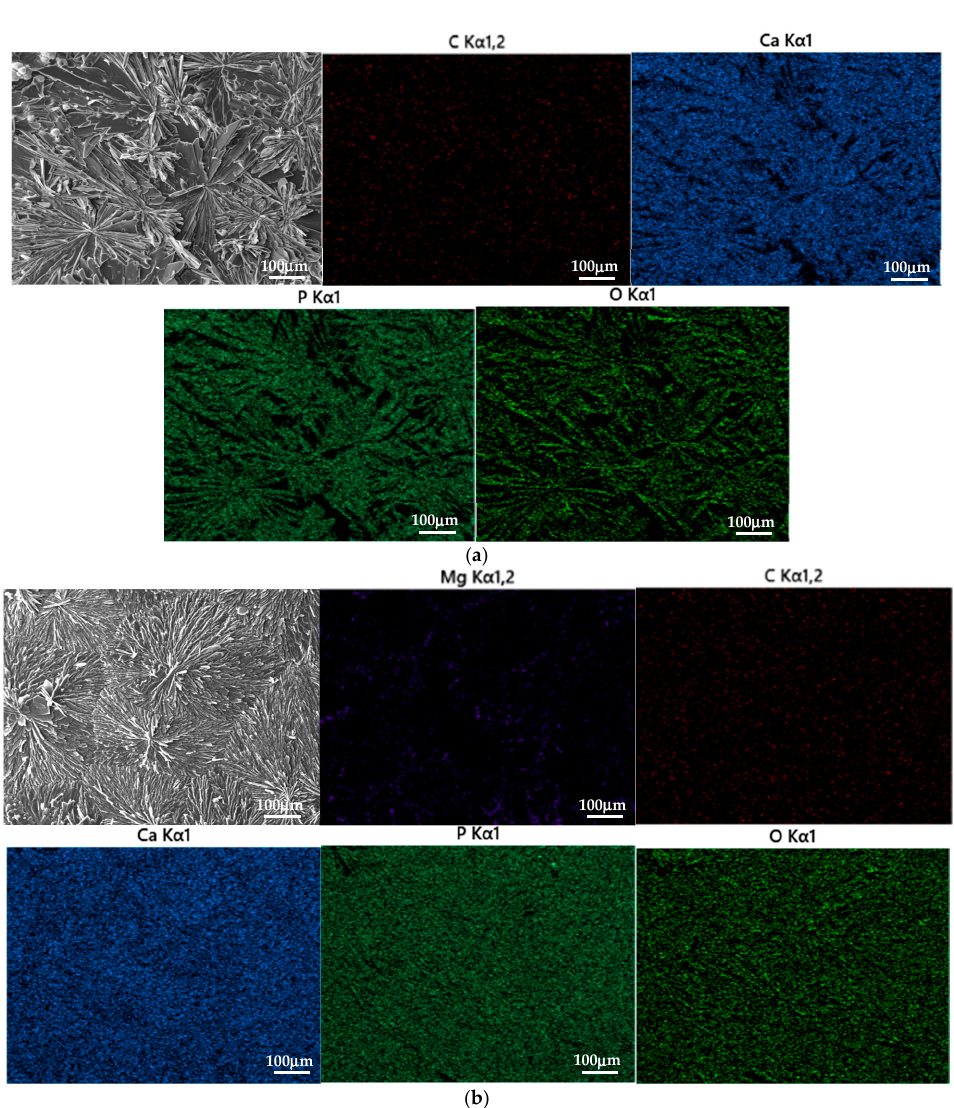
Figure 2. The EDS mappings of: ( a ) C 1 and ( b ) C 2 samples.